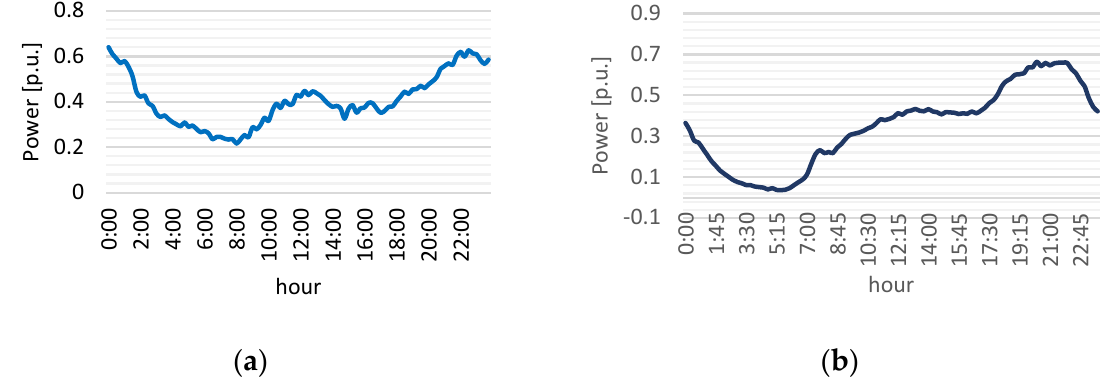
Figure 8. “Residential type profile” obtained in industrial clients I1 (L-S-D) and commercial clients C1 (L-S-D). ( a ) The left curve corresponds to an industrial customer, and ( b ) the right curve corresponds to a commercial customer.